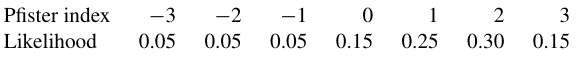
Table 2. Example of the distribution of likelihoods of a well- documented very warm summer with a similar distribution of like- lihoods for +2 (very warm) and +1 (warm). Pfister index Likelihood